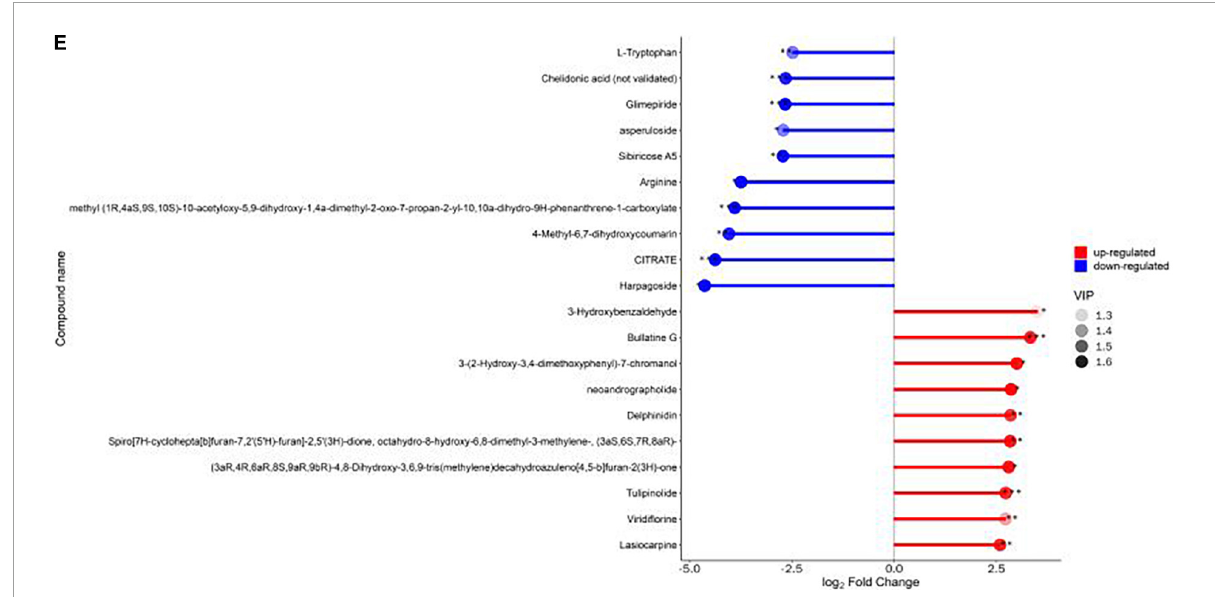
FIGURE5 (A) Classification of the 539 metabolites detected in ethanolic extract of Gym. (B) Classification of the 162 differential metabolites. (C) Volcano plot for 95% ethanol versus 75% ethanol group. (D) Heat map of hierarchical clustering analysis for 95% ethanol versus 75% ethanol group. (E) Matchstick analysis for 95% ethanol versus 75% ethanol